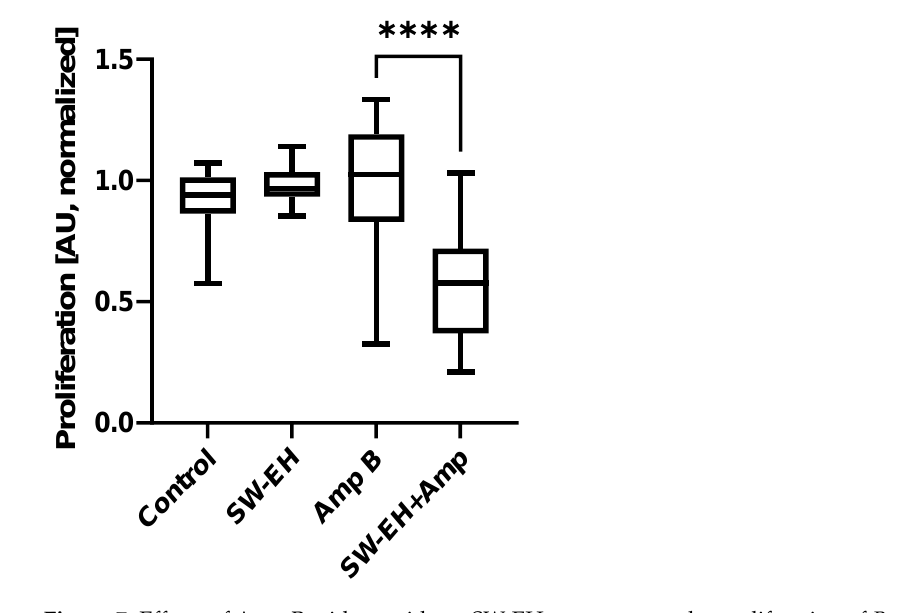
Figure 7. Effects of Amp B with or without SW-EH treatment on the proliferation of R. oryzae grown on a fibrin matrix 12 h post-treatment, showing a significant drop in the combined treatment’s proliferation over the Amp B one (AU 1.0 → 0.58). Proliferation was quantified using the BrdU assay (**** p > 0.0001).